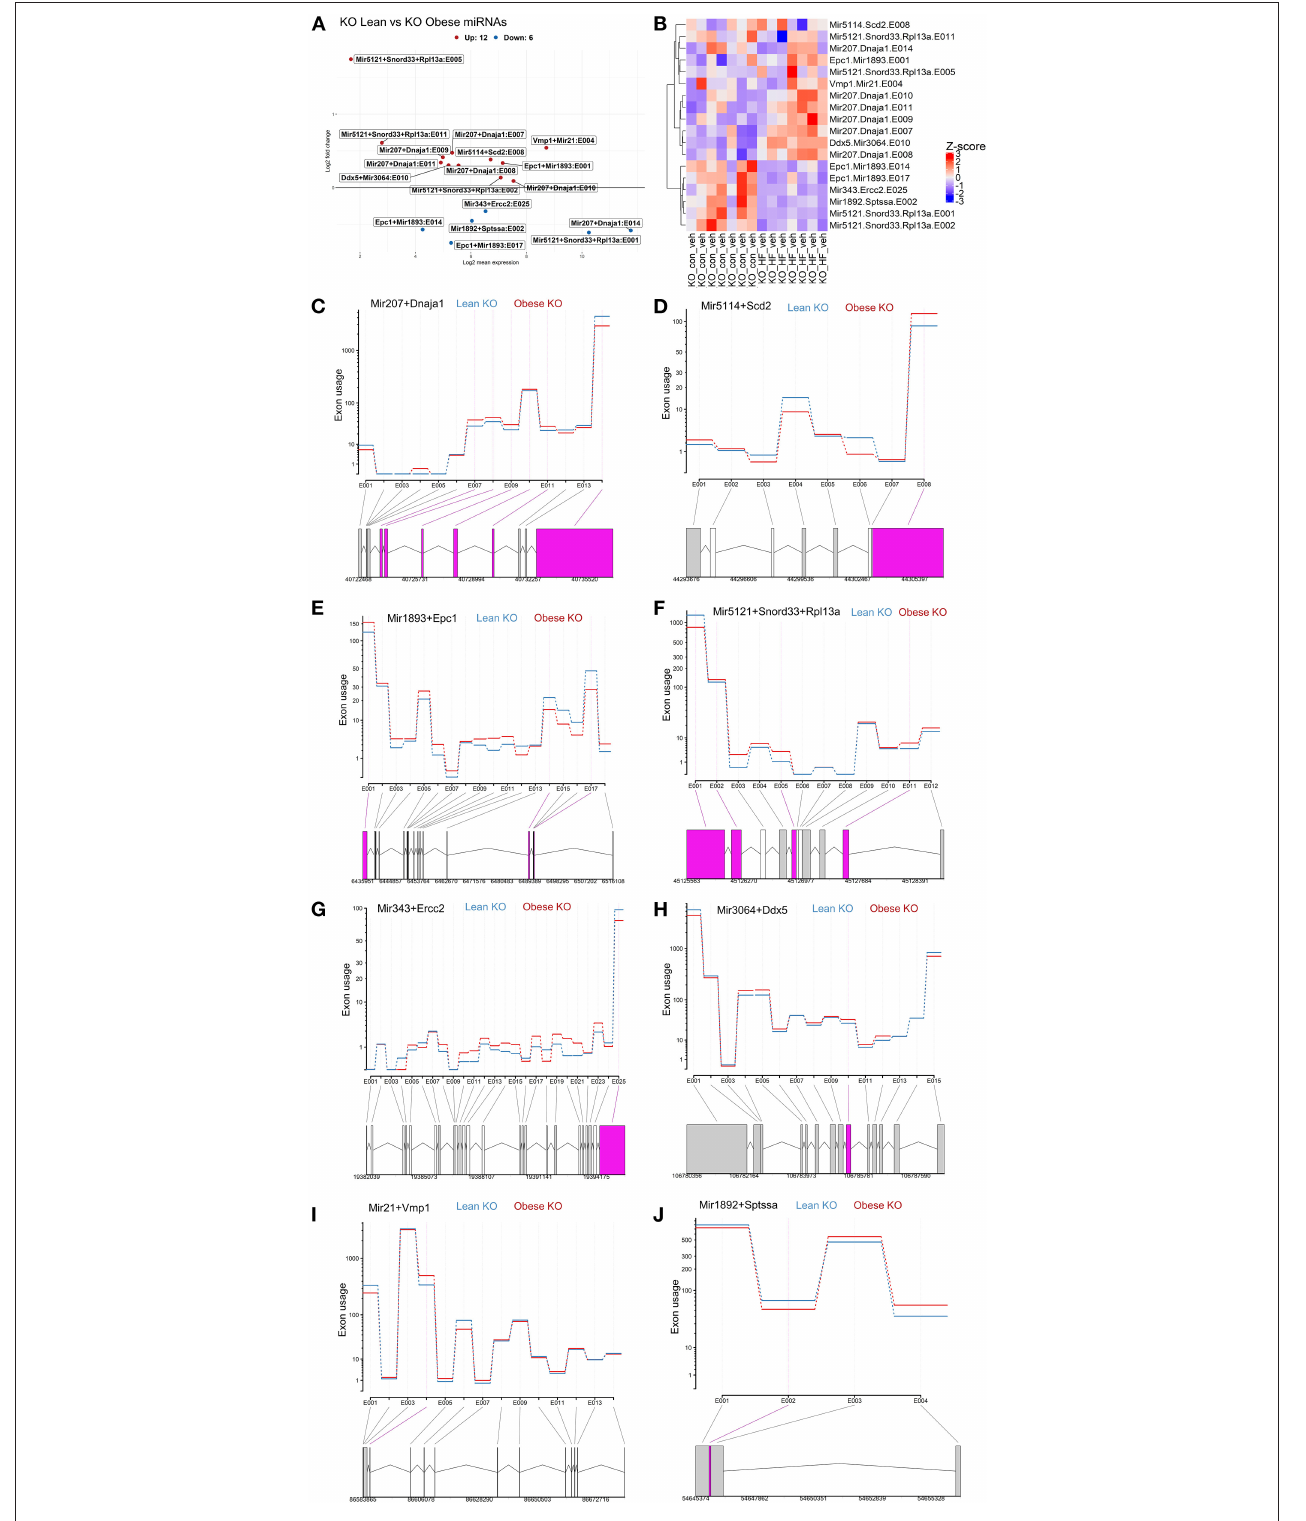
FIGURE 5 | Exon level analyses show differential expression of mirnas between lean and obese ChemR23 KO mice. (A) MA plot between ChemR23 KO lean and ChemR23 KO obese mice showing miRNAs with a BH-adjusted p-value below 0.1 and Log2 fold change (FC) above one plotted by Log2FC in the y-axis and